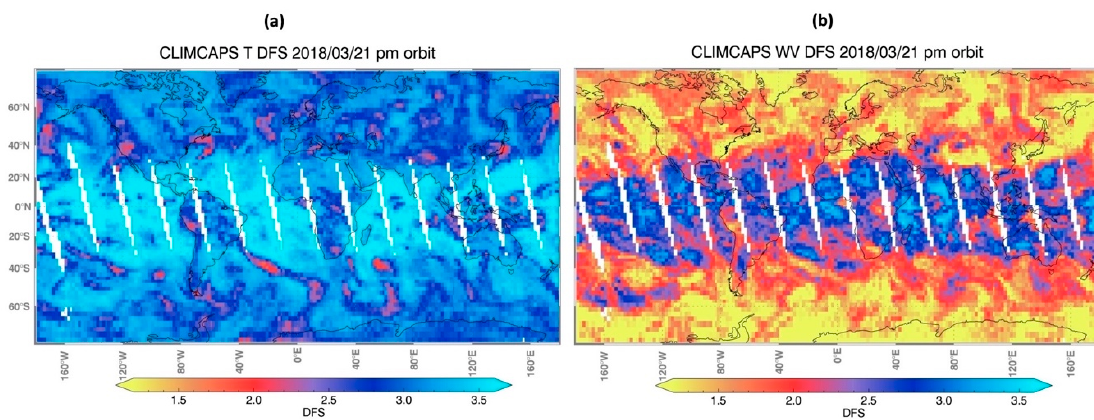
Figure 5. CLIMCAPS scene-dependent information content as quantified by the degrees of freedom (DFS) for ( a ) temperature and ( b ) water vapor retrievals from an ascending SNPP orbit (daytime) of CrIS measurements on 21 March 2018.